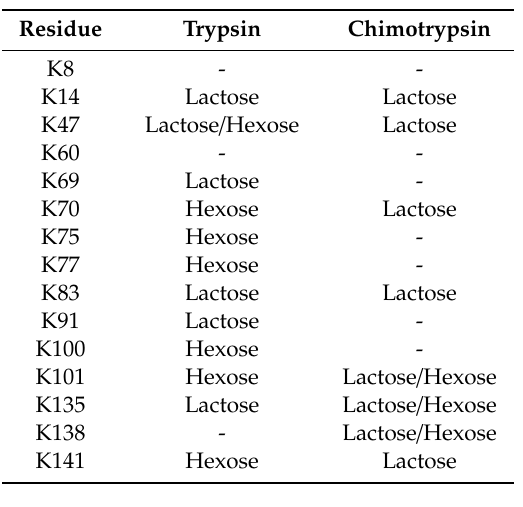
Table 3. Glycation sites identified in β -lactoglobulin after tryptic and chymotryptic digestion of whey samples from UHT